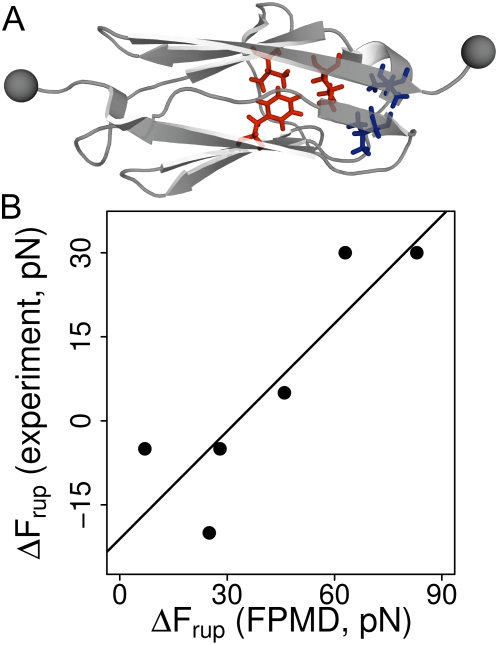
Comparison of in silico rupture forces for the A'G strand with experimental data.(A) Our simulations predict decreased stability of the A'G strand for 5 residues near the A'G strand, rendering them interesting targets for further experimental studies. The figure shows these residues mapped as sticks on the I27 structure. F21, L84 and V71 are colored blue, the experimentally validated V13 and V86 are colored red. (B) Changes in rupture force  from experiment and simulation plotted against each other. The line shows a fit of the data to a linear model. Experimental data for a pulling speed of 10 nm s−1 were extracted from Figure 3, Best et al. 2003 [14].